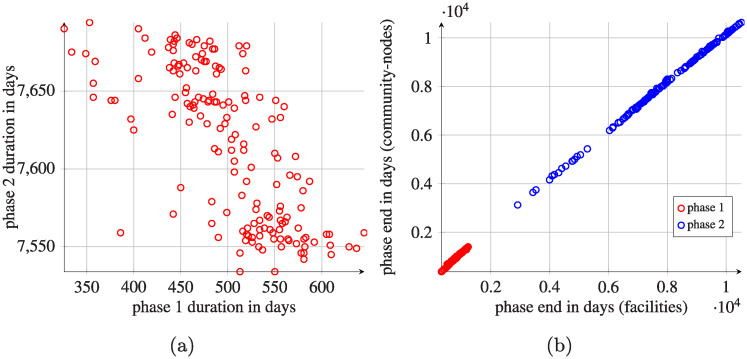
Comparison of average system-wide phase durations and individual phase ends expressed in days in simulations when each healthcare facility was selected as the initial infection point.(a) Phase durations for hospitals and corresponding community nodes. Phase 1 denotes the beginning of the spread (prevalence lower than 10% of the final prevalence); phase 2 denotes the transition state (prevalence < 99.9% final prevalence). The phase durations correspond to a system-wide prevalence, not to individual facility prevalences. (b) Individual phase ends in healthcare facilities and in corresponding community-nodes. Presented results are averaged-out amid all possible initial infection points. Pathogen spread was initiated by a single infectious patient originating from each facility.